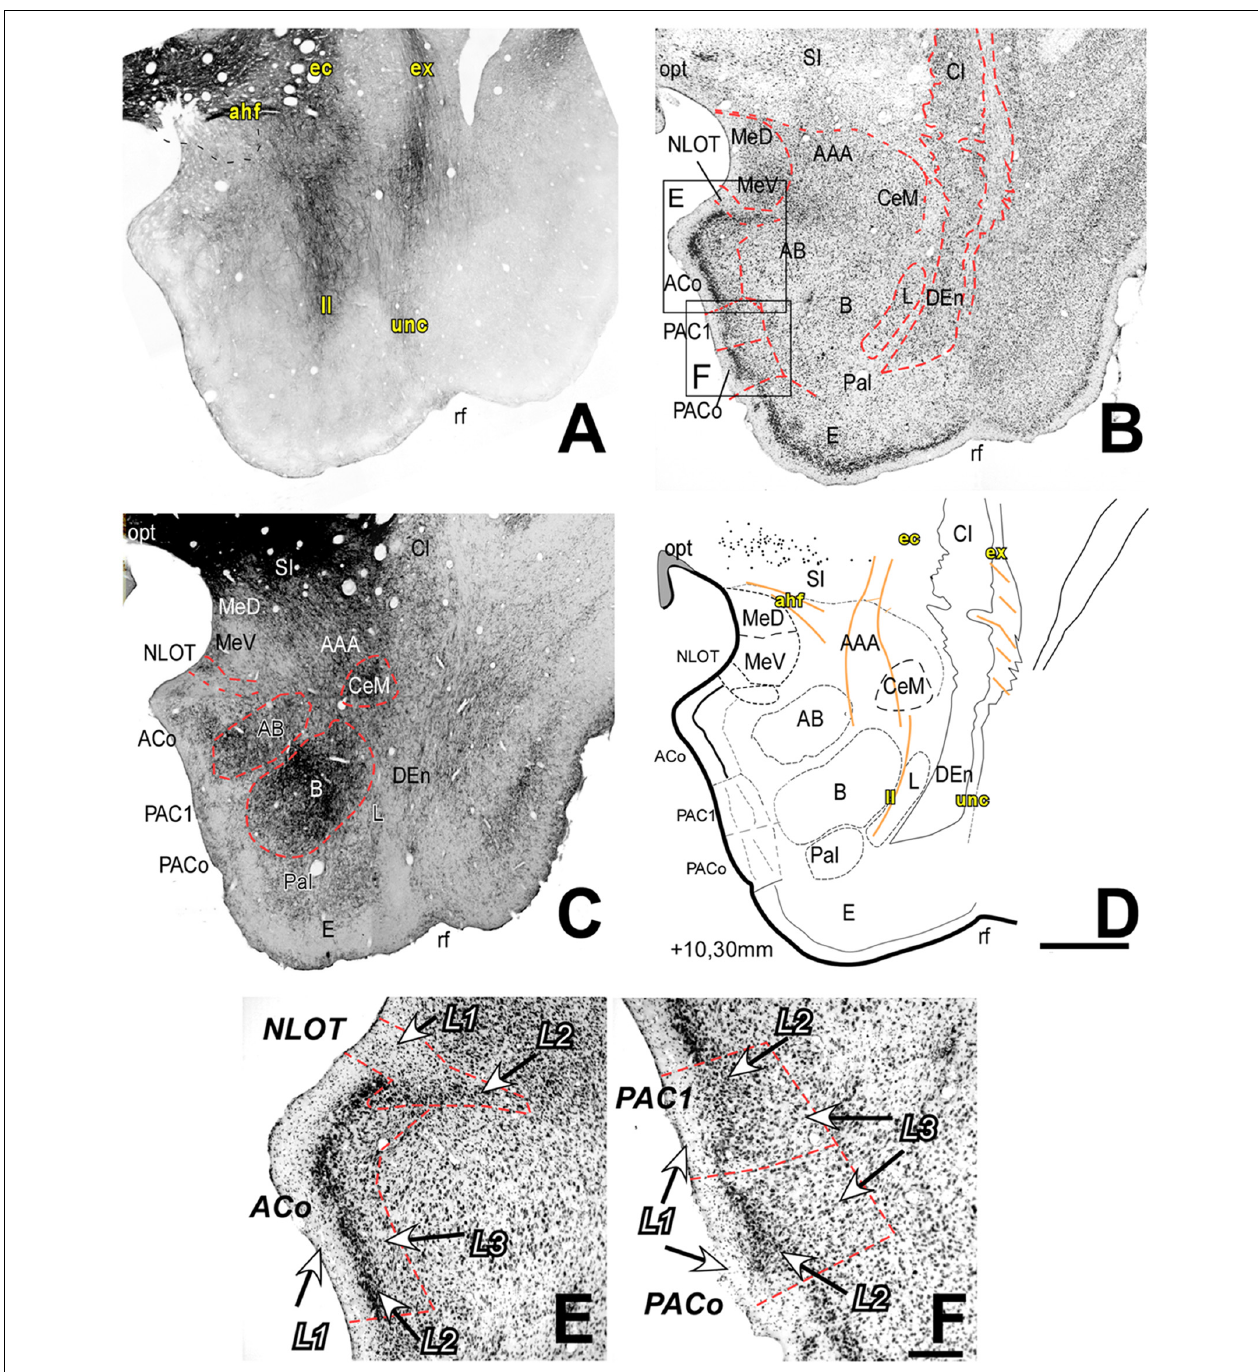
FIGURE 1 | Myelo- and cytoarchitecture of the amygdaloid complex (AC), level 1 (Interaural 10.30 mm). Series of adjacent coronal sections stained for Gallyas (A) , Nissl (B) and acetylcholinesterase (AChE) (C) and the corresponding drawing showing in black the territories of the AC and in orange the myelinic bundles schematically (D) . At this level, it is already possible to identify the deep nuclei, and some of the superficial nuclei and myelin tracts located around and within the nuclei and helping in their delimitation. Unambiguous nuclear boundaries are drawn with a red dashed line in (B,C) . (C) Note the intense staining of AChE in the Basal nucleus (B) and, although heterogeneous, in the accessory basal (AB); CeM showed a markedly high AChE staining level. Panels (E,F) are high magnification bright-field photomicrographs from Nissl-stained sections in the superficial areas of the AC [corresponding to the black squares in (B) ]; the layers are indicated in each region. (E) The anterior cortical nucleus (ACo) contains a densely stained and cell-packed L2; the nucleus of the lateral olfactory tract (NLOT) shows a large L1. (F) PACo (inferior) and periamygdaloid cortex (PAC) 1 (superior). Note the different cell compaction of L2 between these two regions. Scale: 1 mm in (A–D) and 200 µ m in (E,F)